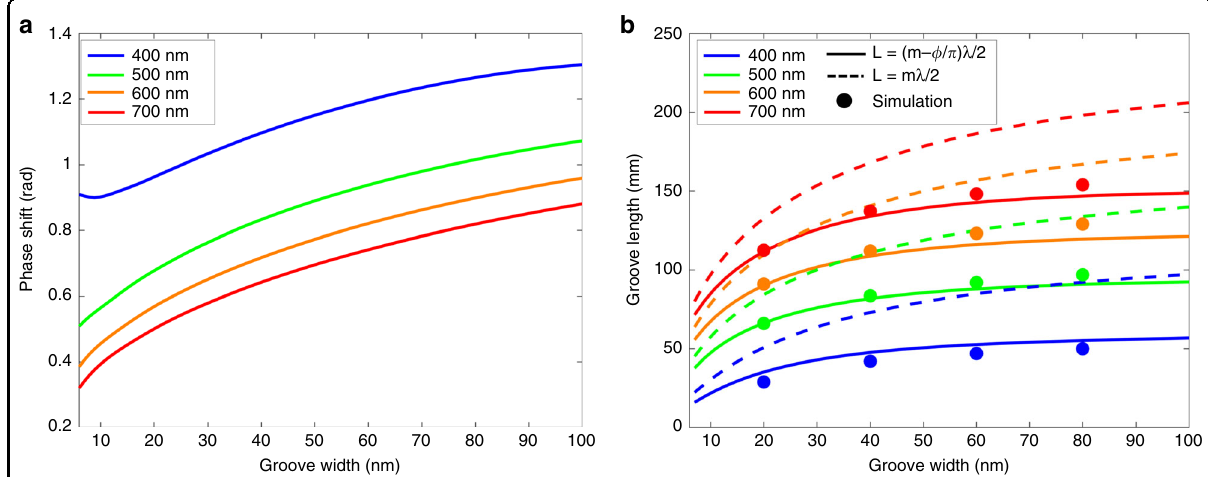
Fig. 2 Boundary phase shift and impact on resonant mode in a single groove. a Analytically calculated phase shift of an Ag-MgF 2 -Ag cavity with respect to groove width in the visible range. b Analytically calculated resonant groove length of the same cavity in relation to the groove width and length with (solid lines) and without (dotted lines) the inclusion of the phase shift φ at the boundary. Numerical simulation data (circular markers) are shown for select geometries. The presented data is for the fi rst resonant mode m =